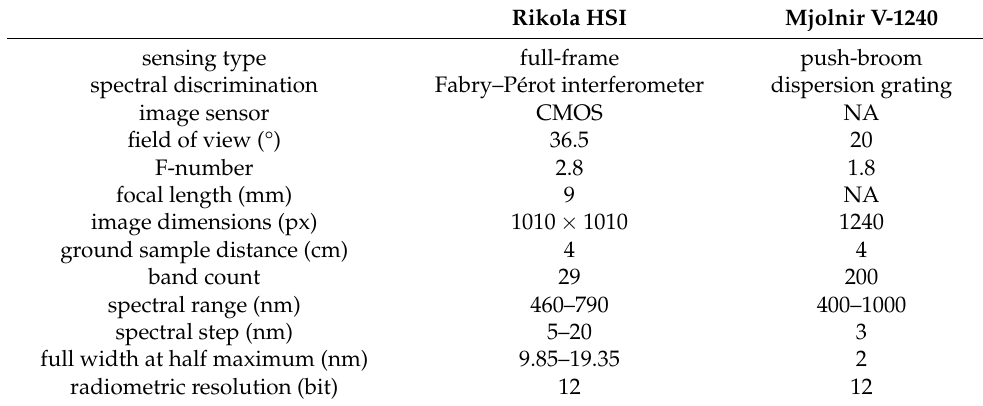
radiometric resolution (bit) 12